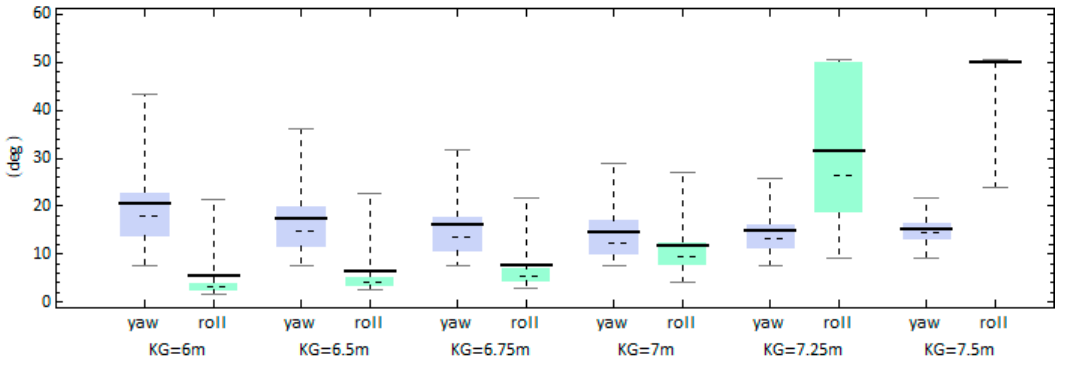
Figure 18. Maximum relative yaw and roll angles observed.